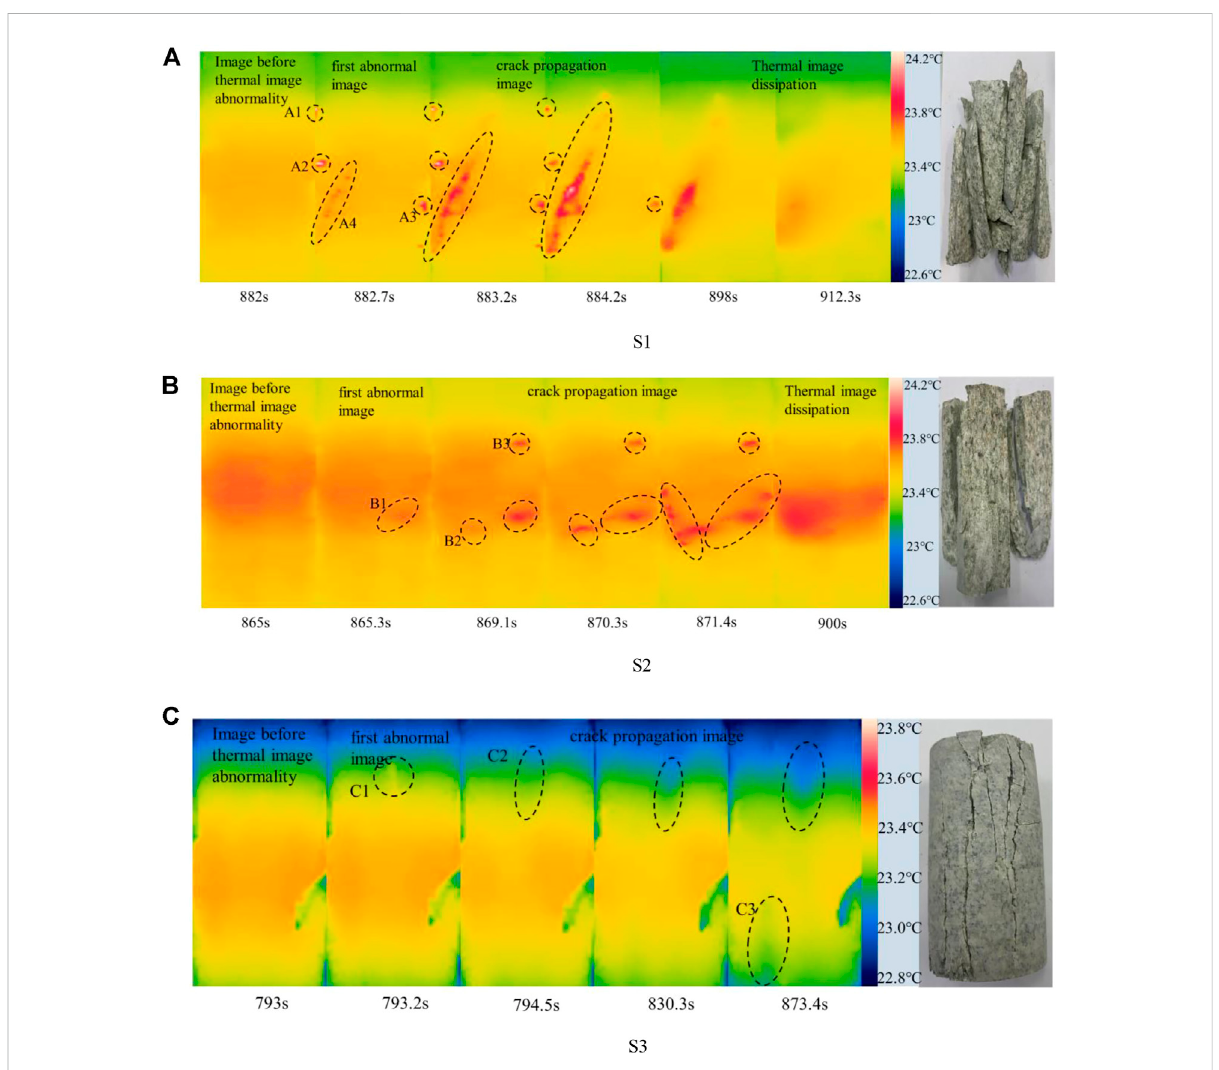
FIGURE 9 Evolution of thermal images at typical moments during granite loading under different freeze-thaw conditions. (A) S1 (B) S2 (C) S3.